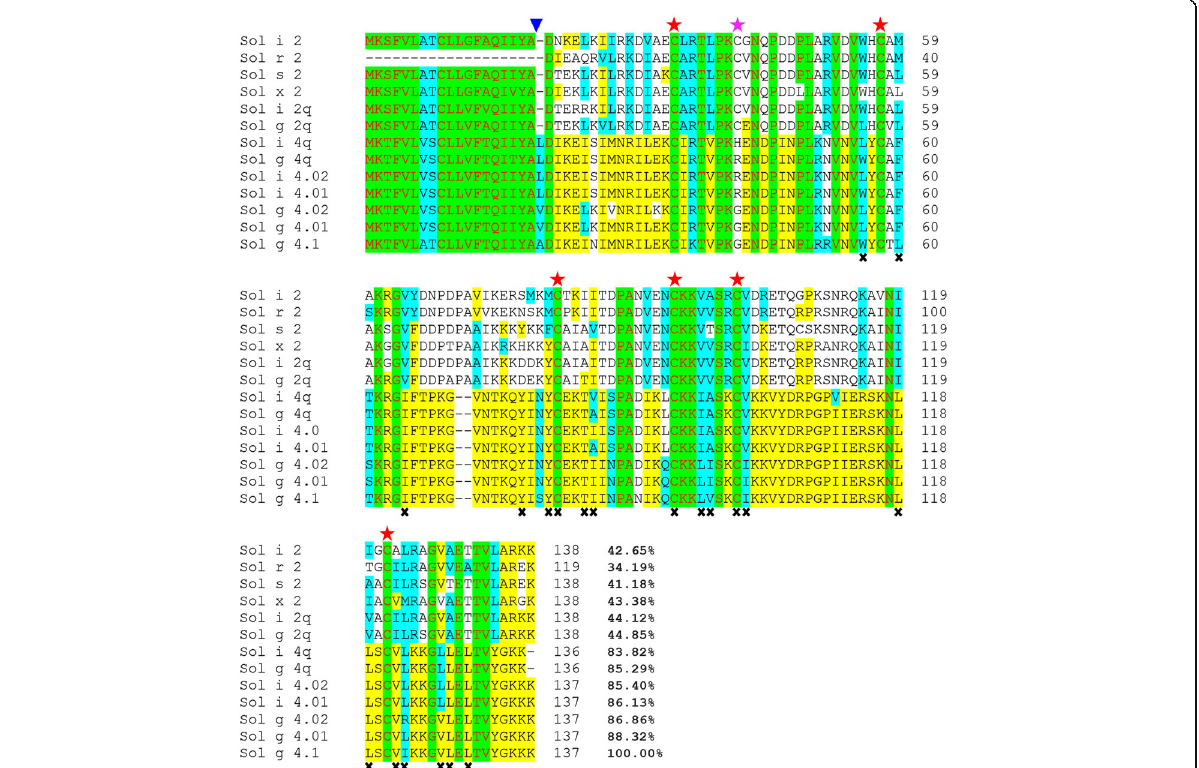
Fig. 2 Alignment of the deduced amino acid sequences of the Sol g 4.1 protein with other Solenopsis 2 and 4 venom proteins from S. invicta , S. geminata , S. saevissima , S. xyloni and S. richteri : conserved (red letters, green region), identical (yellow region), and groups of similar (turquois region) or non-similar (black letters, no color region) residues are shown. The end of the signal sequence is indicated by a blue triangle ( ). Alignment of the six cysteines (red stars) between all Solenopsis 2 and 4 genes and the alignment of the seventh cysteine in the Sol 2 genes (pink star). Residues lining the interior face of the Sol g 4.1 protein are indicated by x . The sequences were submitted to GenBank with the following accession numbers: Solenopsis 2 proteins: P35775 for Sol i 2, P35776 for Sol r 2, ABC58726 for Sol s 2, ALM98859 for Sol × 2, AAY32928 for Sol i 2q and AAY32926 for Sol g 2q; and Solenopsis 4 proteins: AAC97369 for Sol i 4.01, AAC97370 for Sol i 4.02, AAF65312 for Sol g 4.01,